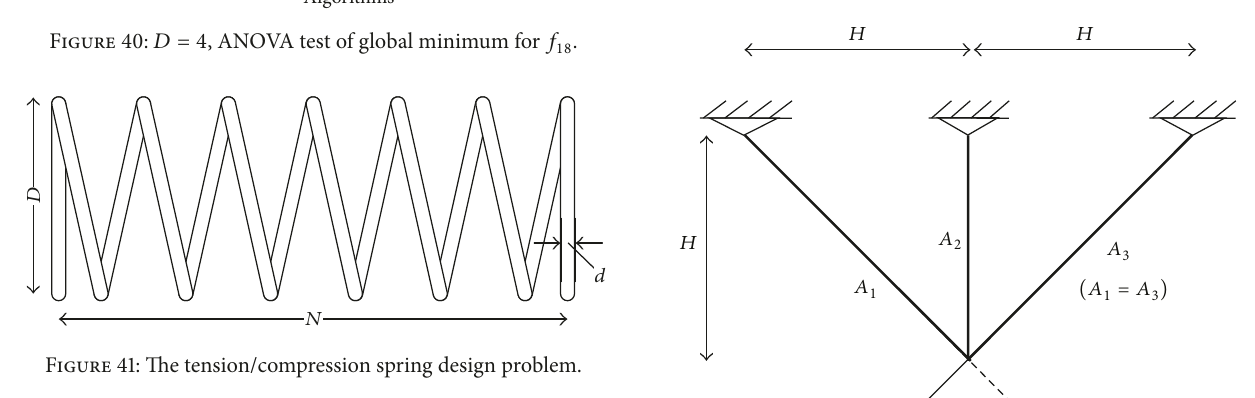
Figure 44: The welded beam design problem.